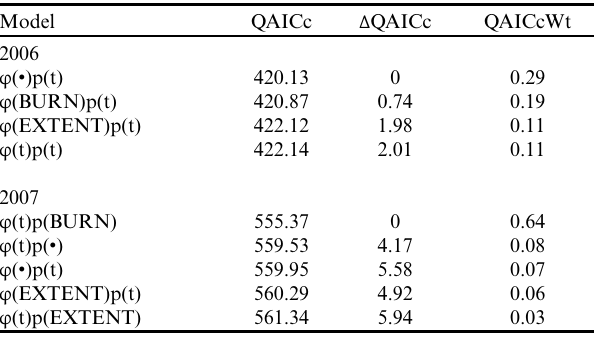
Table 3 . Model selection for the effects of nesting-season prescribed fire (BURN) and extent of fire (EXTENT) on male Bachman’s Sparrows ( Peucaea aestivalis ) monthly survival during 2006 and 2007. The top five models are shown for each year, but the confidence set included only those models with a Δ QAICc < 2.0. φ , probability of survival; p, probability of resighting; t, time